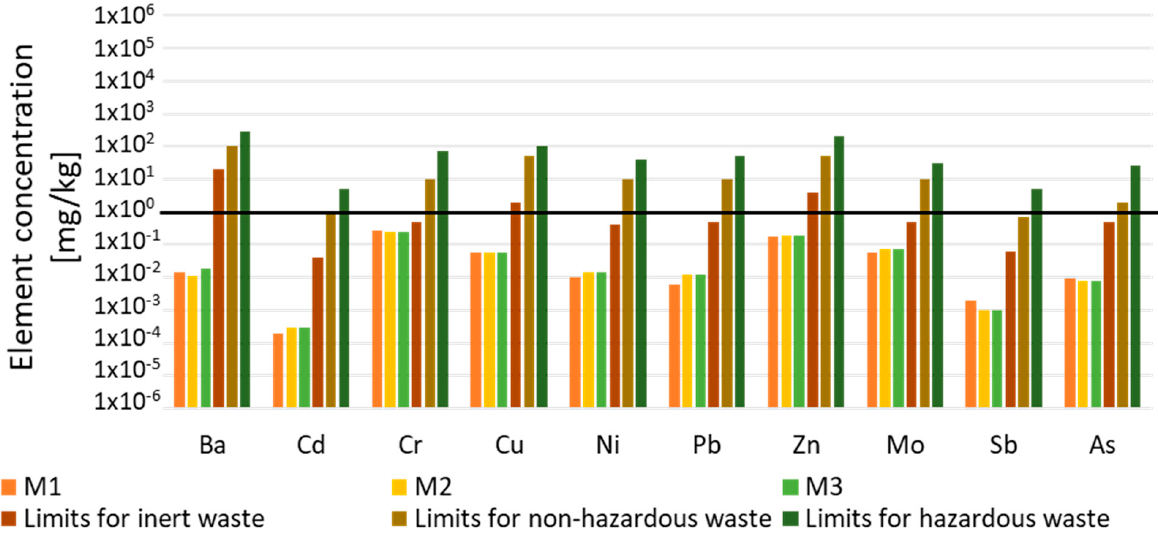
Figure 9. Heavy metals (mg/L) in M1, M2 and M3 AACs after the leaching test in water (EN 12457-2) and comparison with the limits defined in 2003/33/EC for inert, non-hazardous and hazardous wastes (the error associated with the measure is 30%).